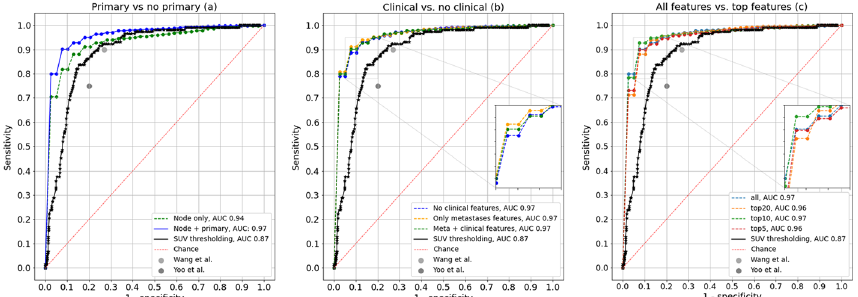
Fig. 3 Overview of ROC curves for the XGB classifier models with and without the inclusion of primary tumour features (left), with and without the inclusion of additional clinical knowledge (middle) and a selection of features (right). For reference, the SUV threshold model is also shown. The performance of doctors is taken from Wang et al. [24] and Yoo et al.